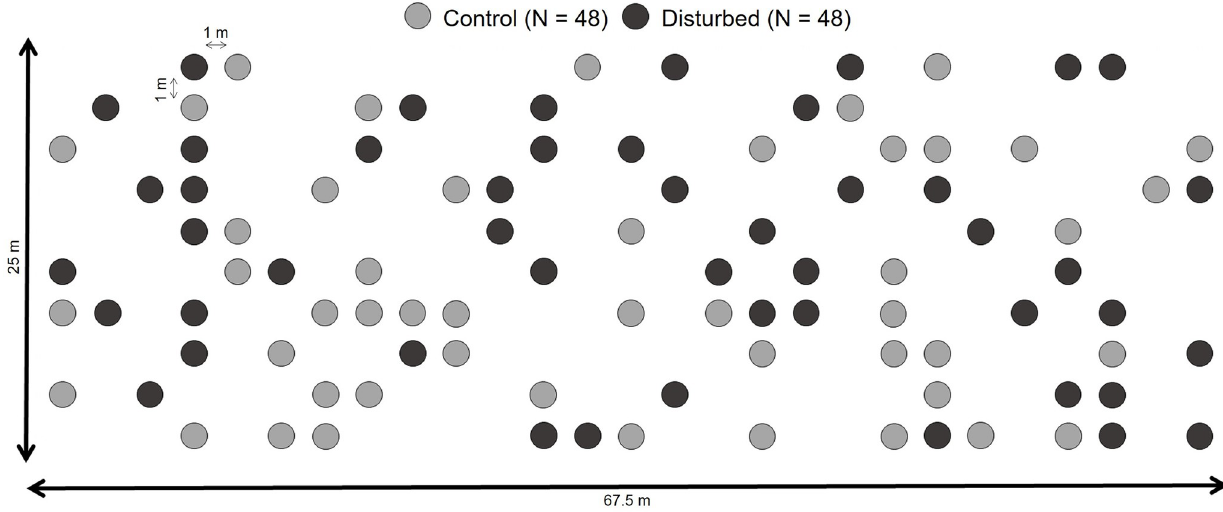
Fig 1. Layout of plots within the study site. The study site consists of a 67.5 m x 25 m old-field divided into 10 x 27 1 m diameter circular plots, with each plot separated by 1 m wide laneways. Forty-eight plots were randomly assigned to each treatment, control or disturbed. Light grey circles mark control plots, and dark grey circles represent disturbed